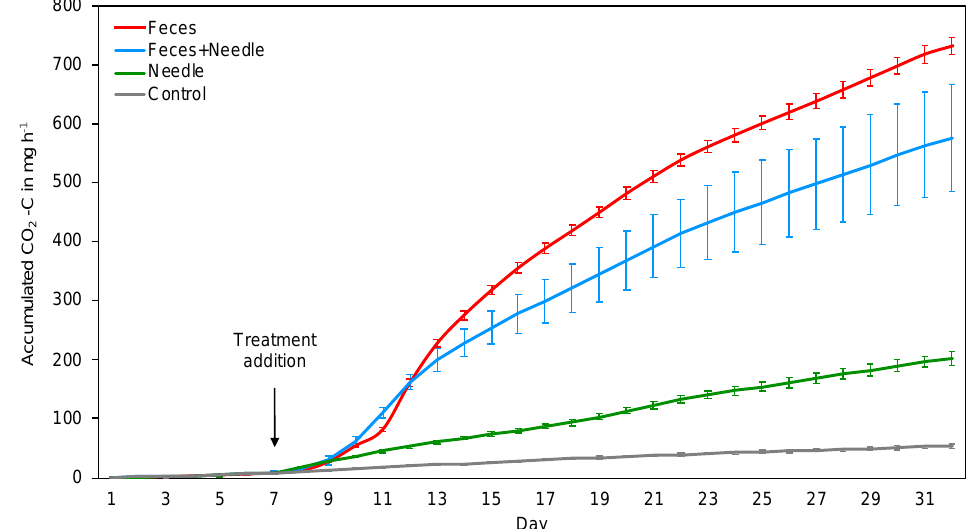
Figure 3. Accumulated CO 2 -C flux (mg h −1 ) of the incubators with treatments of feces from the pine-tree lappet ( Denrolimus pini L.), feces plus Scots pine ( Pinus Sylvestris L.) needle litter, needle litter, and a control with soil only during the 31 days of the incubation experiment. Treatments were added on day 7 with n = 5. A total of 12 measurements per day were conducted.